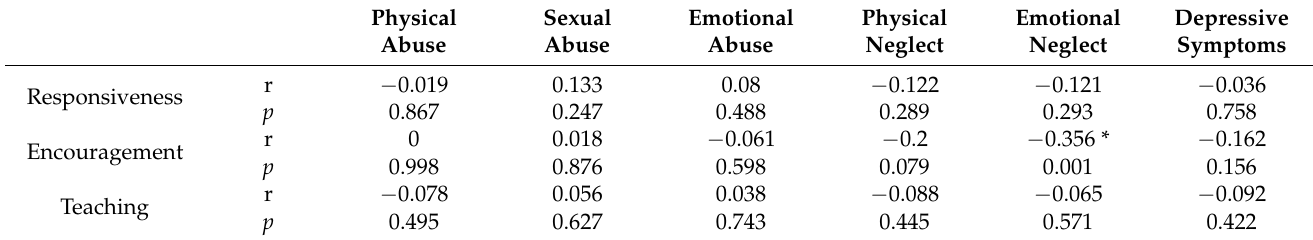
Table 5. Partial correlation controlling for the mothers’ education level.